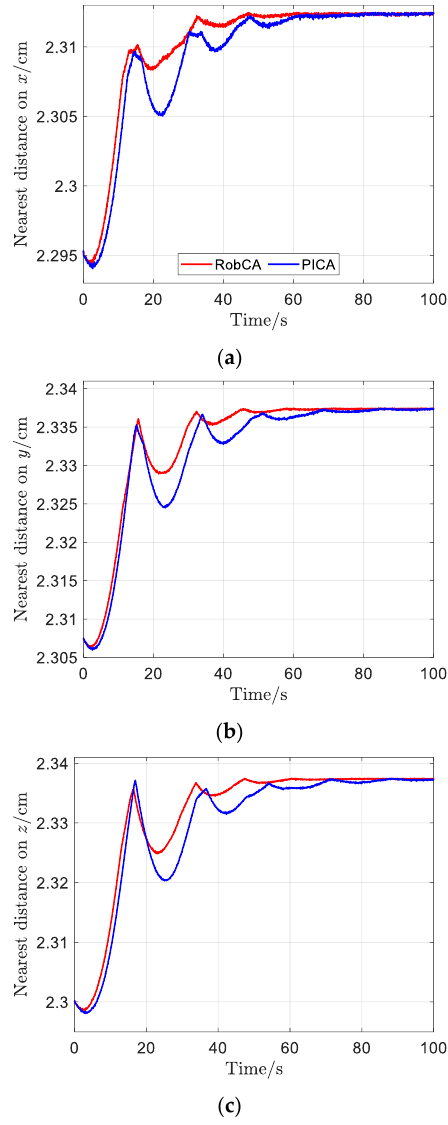
Figure 9. The nearest distance between the test mass and the electrode house with the RobCA method and the PICA method. ( a ) Nearest distance on x. ( b ) Nearest distance on y. ( c ) Nearest distance on z.